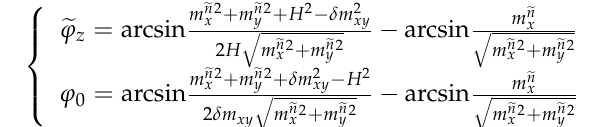
The heading (cid:101) ϕ z and the angle ϕ 0 can be obtained by solving Equation (7). Appendix B shows the derivation process.